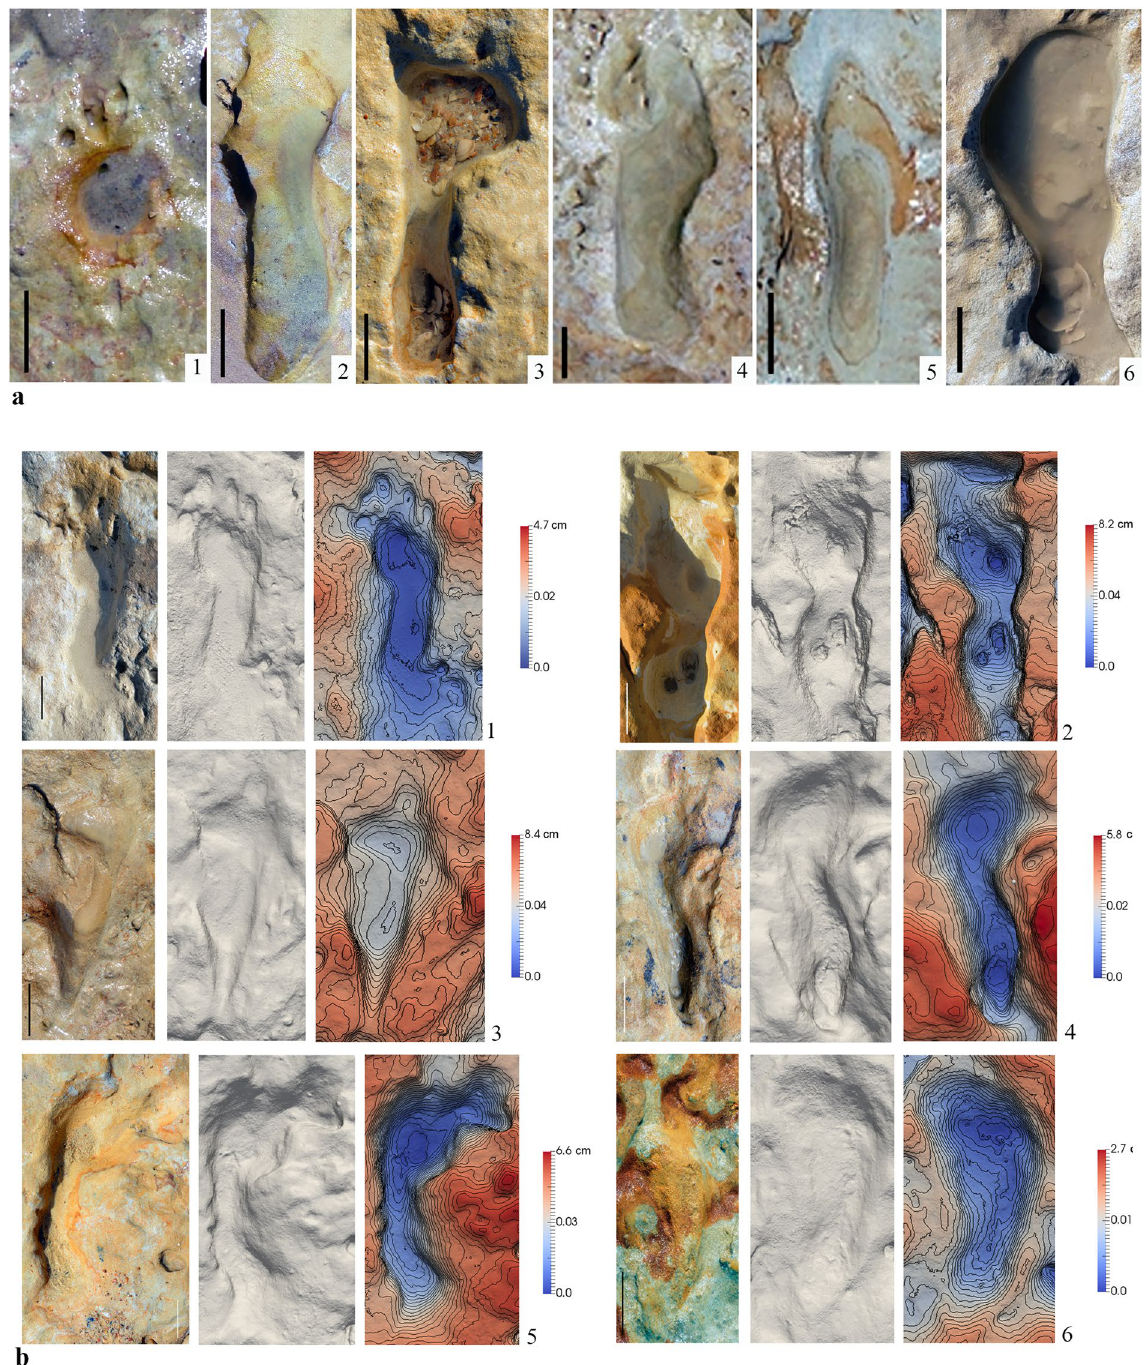
Figure 4. Hominin footprints from Matalascañas site. ( a ) Detail view of some footprints. ( a1 ) M2020-93, ( a2 ) M2020-17, ( a3 ) M2020-15, ( a4 ) M2020-06, ( a5 ) M2020-08, ( a6 ) M2020-14. Scale bar, 5 cm. Natural views, solid models and shaded 3D elevation with contour lines images. ( b1 ) M2020-12, ( b2 ) M2020-22, ( b3 ) M2020-19, ( b4 ) M2020-18, ( b5 ) M2020-20, ( b6 ) M2020-21. Scale bar, 5